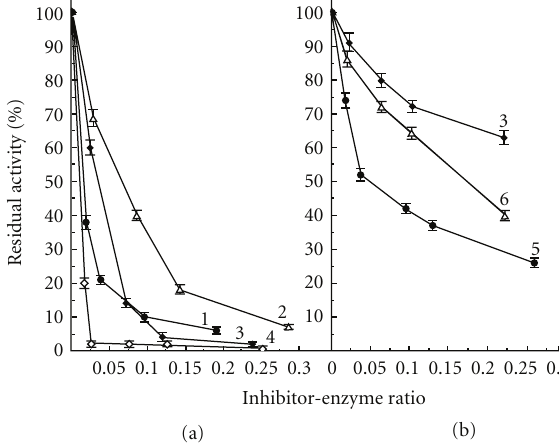
Figure 3: E ff ect of protein proteinase inhibitors on amidase activities (%) of R. solani (a) and F. culmorum (b) exoproteinases. 1—trypsin inhibitor from potato tubers [27], 2—chymotrypsin I inhibitor [30], 3—SKTI, 4—trypsin inhibitor from honey locust seeds [31], 5— subtilisin inhibitor from potato tubers [32], 6—SBBI. For the amidase activity measurements BAPNA and Z-AALPNA were used as the substrates,